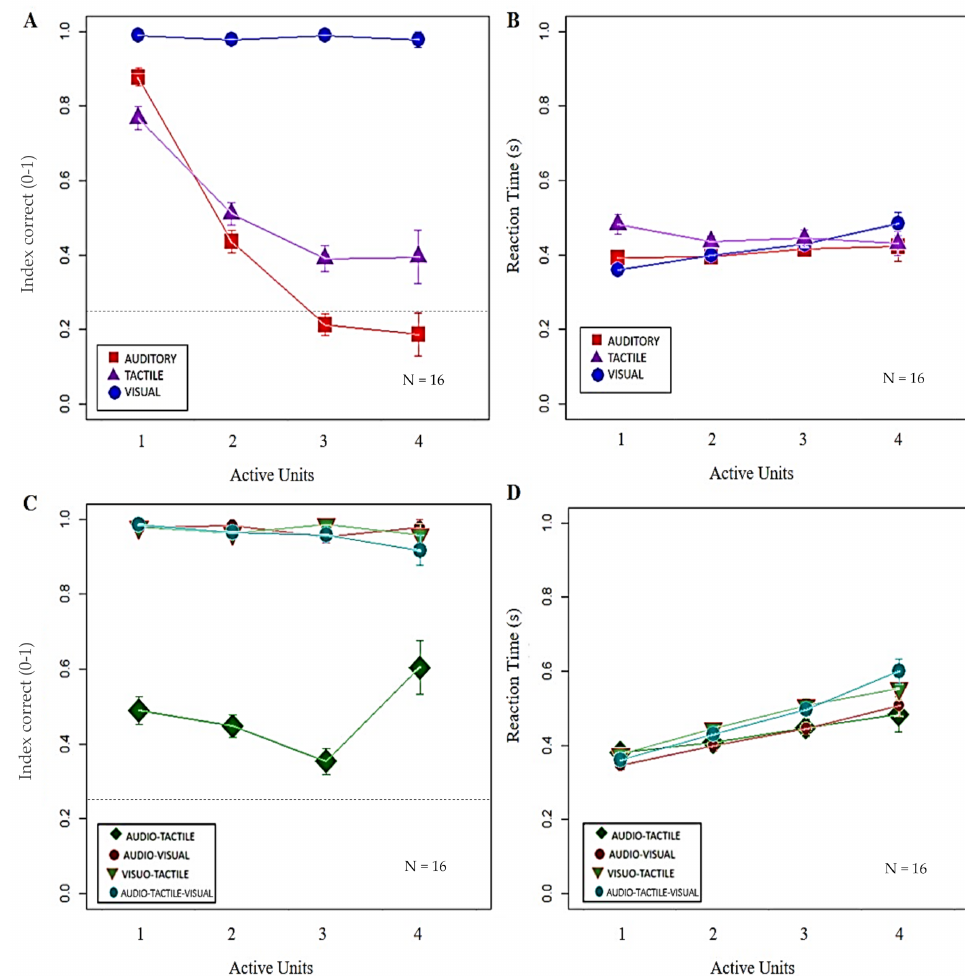
Figure 3. Impact of increasing stimulated area on index correct (IC) and reaction time (RT) with unimodal and multimodal stimuli. In ( A , B ) each symbol represents the mean value with standard error of IC and RT (y-axis), respectively, obtained by all the participants per number of active units (x-axis) with unimodal visual (blue dots), auditory (red squares) and tactile stimuli (purple triangles). The black dashed lines indicate the chance level (0.25). ( A ) Only visual stimuli induced a high IC ( p = 1), regardless of the number of active units, with respect to the linear decrease of auditory ( p < 0.05) and tactile ( p < 0.01) modalities. ( B ) Concerning RT, a linear increase in responsiveness was present in case of visual stimuli ( p < 0.01), but not auditory or tactile stimuli ( p = 1). In ( C , D ) each symbol represents the mean value with standard error of IC and RT (y-axis), respectively, obtained by all the participants per number of active units (x-axis) with bimodal audio-tactile (green rectangle), audio-visual (dark-red dots), and visuo-tactile (red and green triangle) stimuli, and with trimodal audio-tactile-visual (light-blue dots) stimuli. ( C ) When bimodal conditions included visual stimuli, IC maintained a high value, independently from the number of active units ( p = 1), while IC were lower for audio-tactile stimuli with no significant differences between different dimensions of stimulated areas ( p > 0.10). ( D ) In opposition to the trend of IC, RT linearly delayed only in presence of visual stimuli ( p < 0.05), while no significant difference was experienced with audio-tactile stimuli ( p >